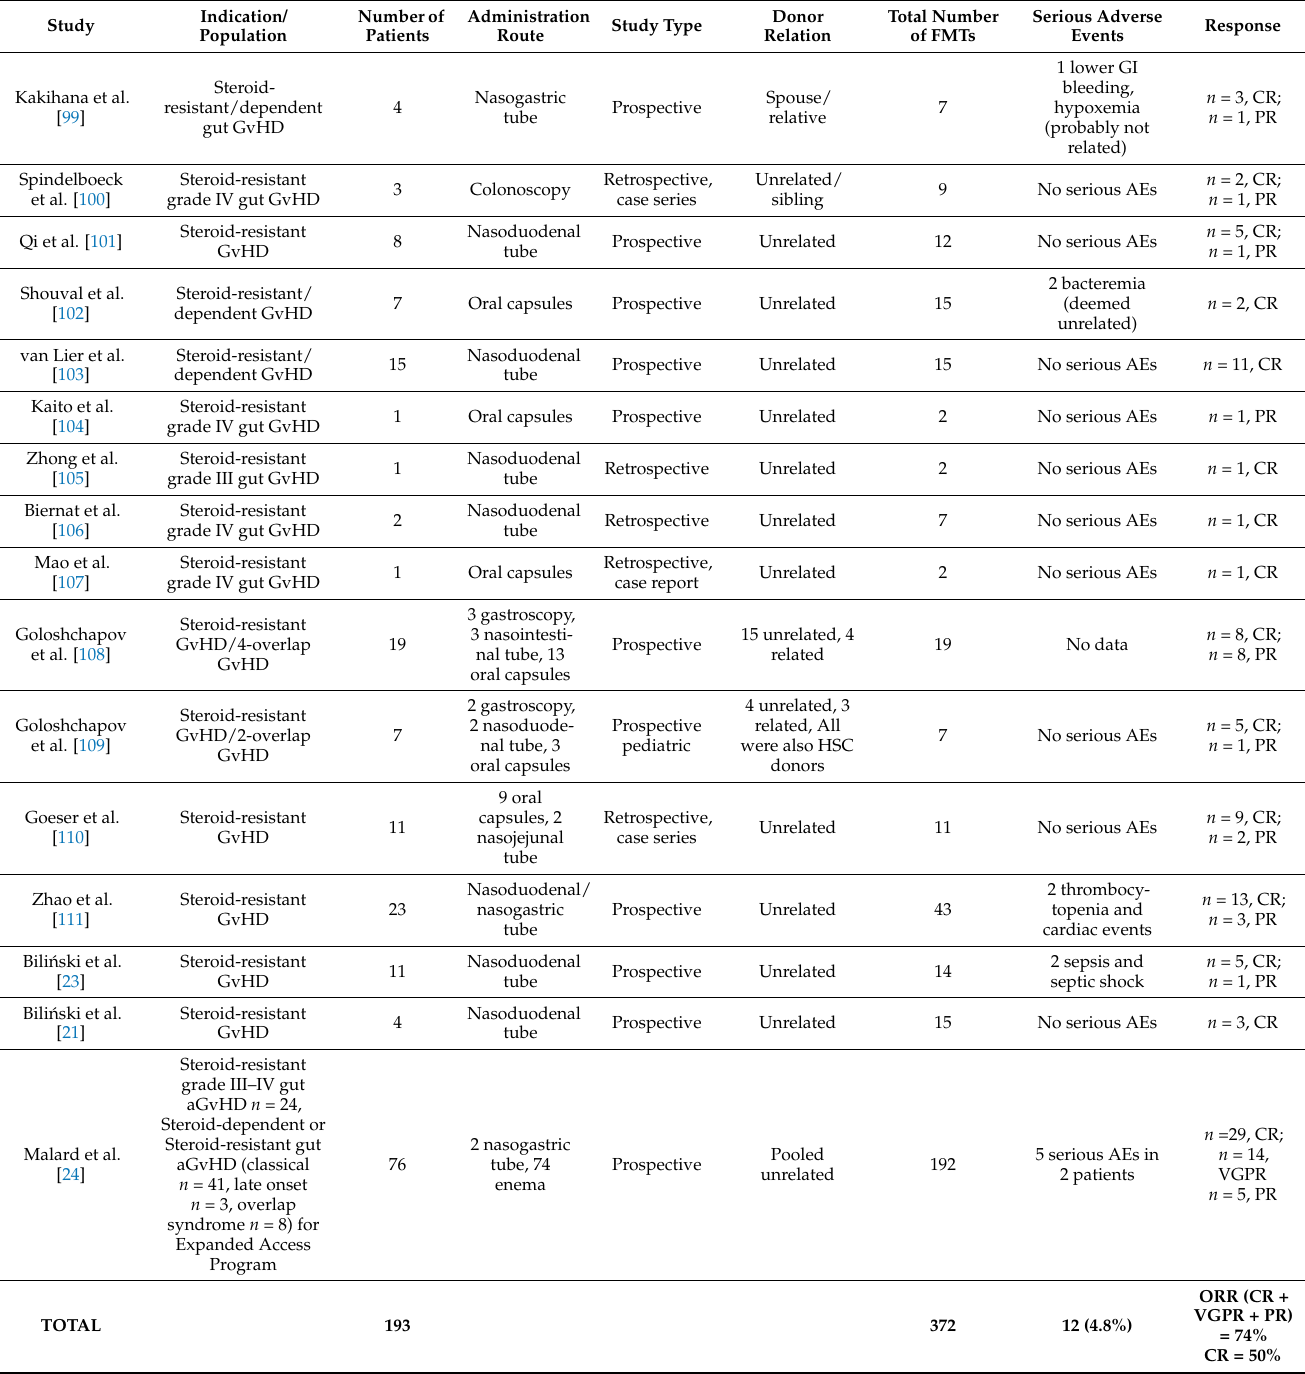
Table 1. Clinical studies and trials on fecal microbiota transplantation in GvHD